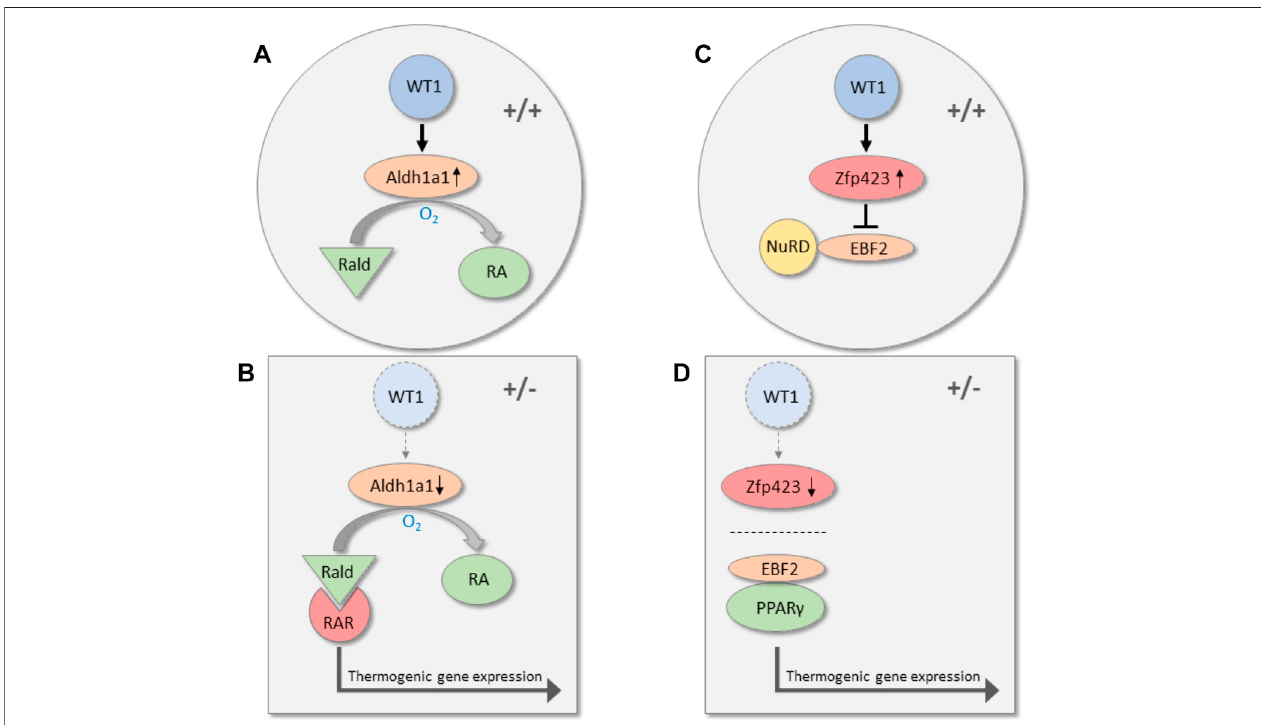
FIGURE 2 | Transcriptional pathways along which WT1 may repress thermogenic genes in visceral WAT. In wild-type mice (+/+), WT1 increases the expression of Aldh1a1, which catalyzes the oxidation of retinaldehyde (Rald) to retinoic acid (RA) (A) . Reduction of Aldh1a1 in visceral WAT of heterozygous Wt1 knockout mice (+/ − ) causes accumulation of retinaldehyde (Rald), which stimulates thermogenic gene expression via retinoic acid receptor (RAR) activation (B) . (Kiefer et al., 2012) WT1 is also required for normal expression of the transcription factor Zfp423 in visceral WAT. Zfp423 recruits the NuRD co-repressor complex and thereby prevents the transcription factor EBF2 from activating thermogenic genes (C) . (Shao et al., 2021). Zfp423 is reduced in visceral WAT of mice with a single Wt1 allele (+/ − ). (Kirschner et al., 2022). As a consequence, interaction of PPAR γ with EBF2 shifts the occupancy to thermogenic gene promoters and induces thermogenic gene expression (D) .